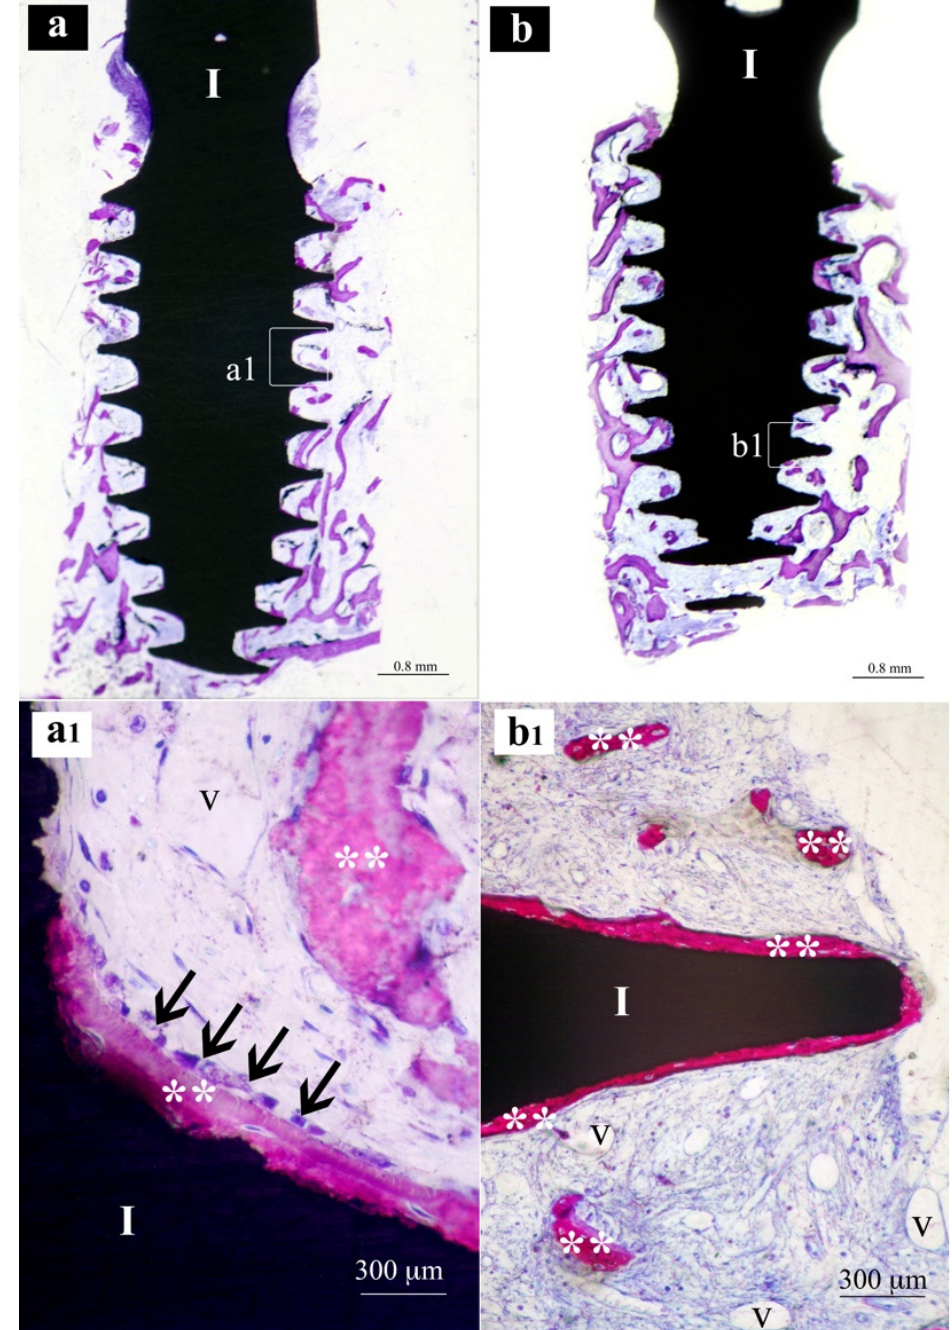
Figure 4. Central sections of two implants of the SLA group after 6 weeks of healing. In ( a , b ), original magnifications ( × 12), the implant bodies (I) appear to be, in the threaded regions, surrounded by much more bone tissue than in Figure 3. In ( a1 , b1 ), original magnifications ( × 200), the implant threads (I) appear to be in a more advanced phase of osseointegration. **, newly formed bone; V, vessel; black arrows, osteoblastic cells.